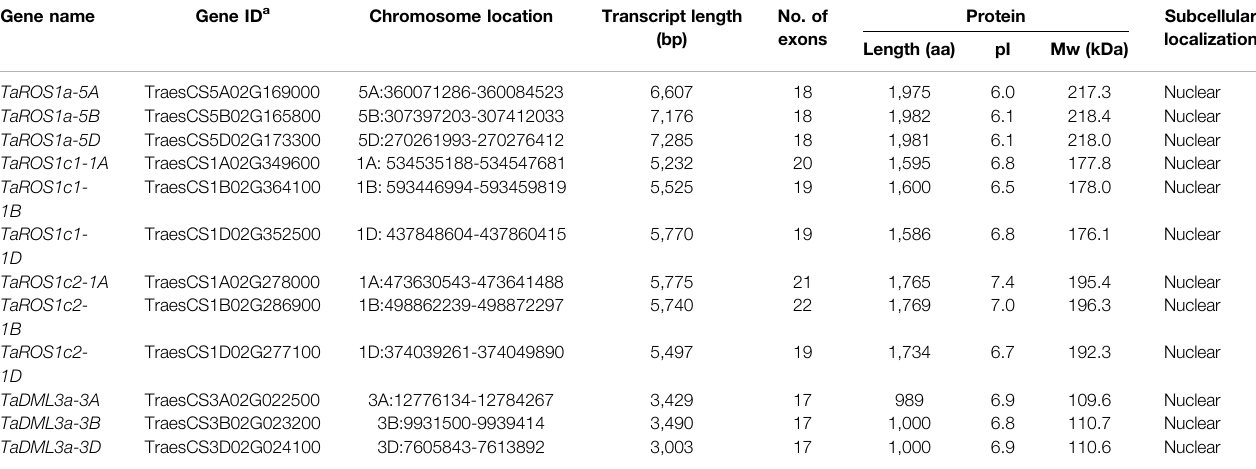
TABLE 1 | Summary and characteristics of dMTase genes identi fi ed in